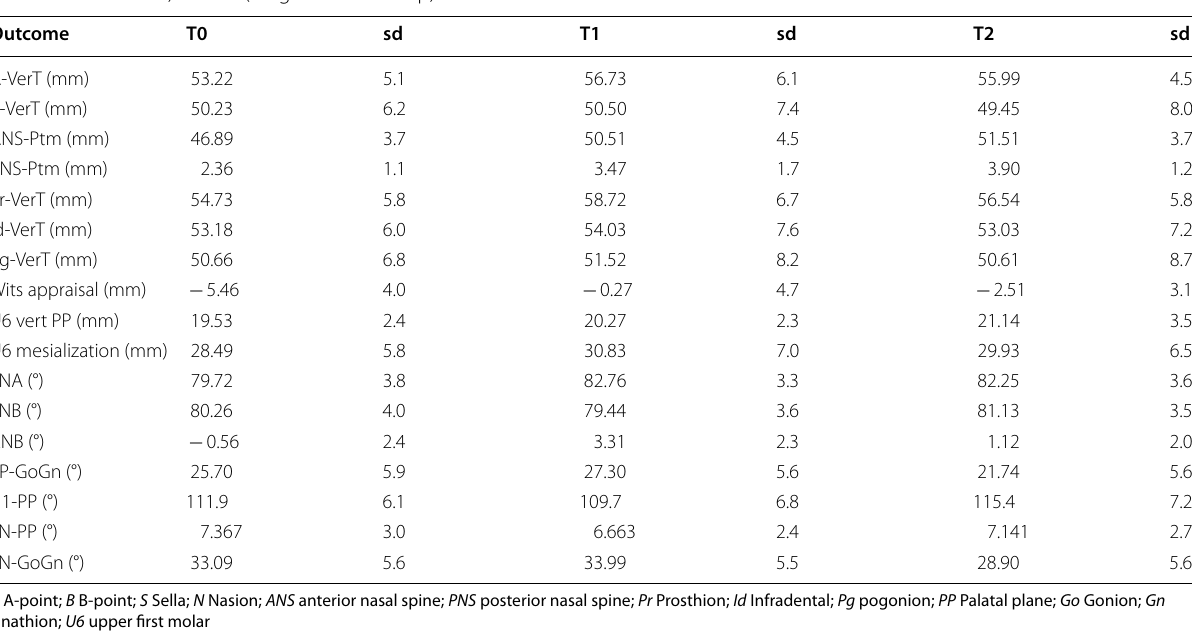
Table 2 Descriptive analysis (mean and standard deviation) of the cephalometric measurements at T0 (pre-treatment), T1 (post- facemask treatment) and T2 (long-term follow up)